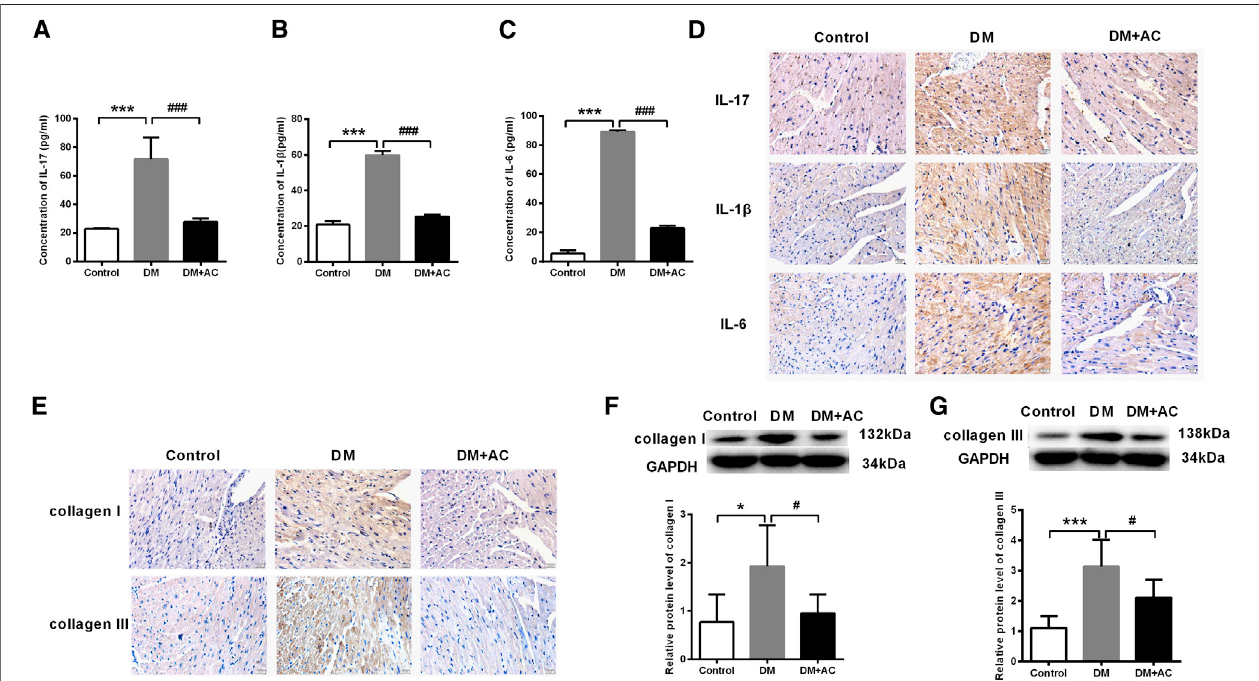
FIGURE 2 | Anthocyanin attenuates in fl ammation and myocardial fi brosis in diabetic mice. (A) Concentration of interleukin (IL)-17 detected by enzyme-linked immunosorbent assay (ELISA). (B) Concentration of IL-1 β detected by ELISA. (C) Concentration ofIL-6 detected by ELISA. (D) Immunohistochemistry analysis of IL-17 ( fi rst lane), IL-1 β (second lane), and IL-6 (third lane). Scale bar: 20 μ m. (E) Immunohistochemistry analysis of collagen I ( fi rst line) and III (second line). Scale bar: 20 μ m. (F) Relative protein level of collagen I. (G) Relative protein level of collagen III. GAPDH served as an internal control. * p < 0.05 vs. Control, *** p < 0.001 vs. Control, # p < 0.05 vs. diabetes mellitus (DM), ### p < 0.001 vs. DM; n (cid:1)